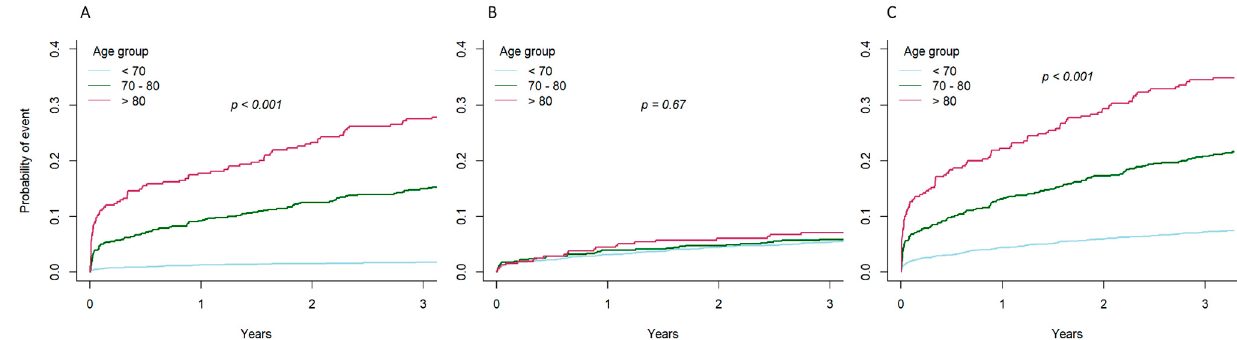
Figure 3. Cumulative incidence function of death according to age. ( A ) Probability of noncardiovascular death; ( B ) proba- bility of cardiovascular death; ( C ) probability of all-cause death.